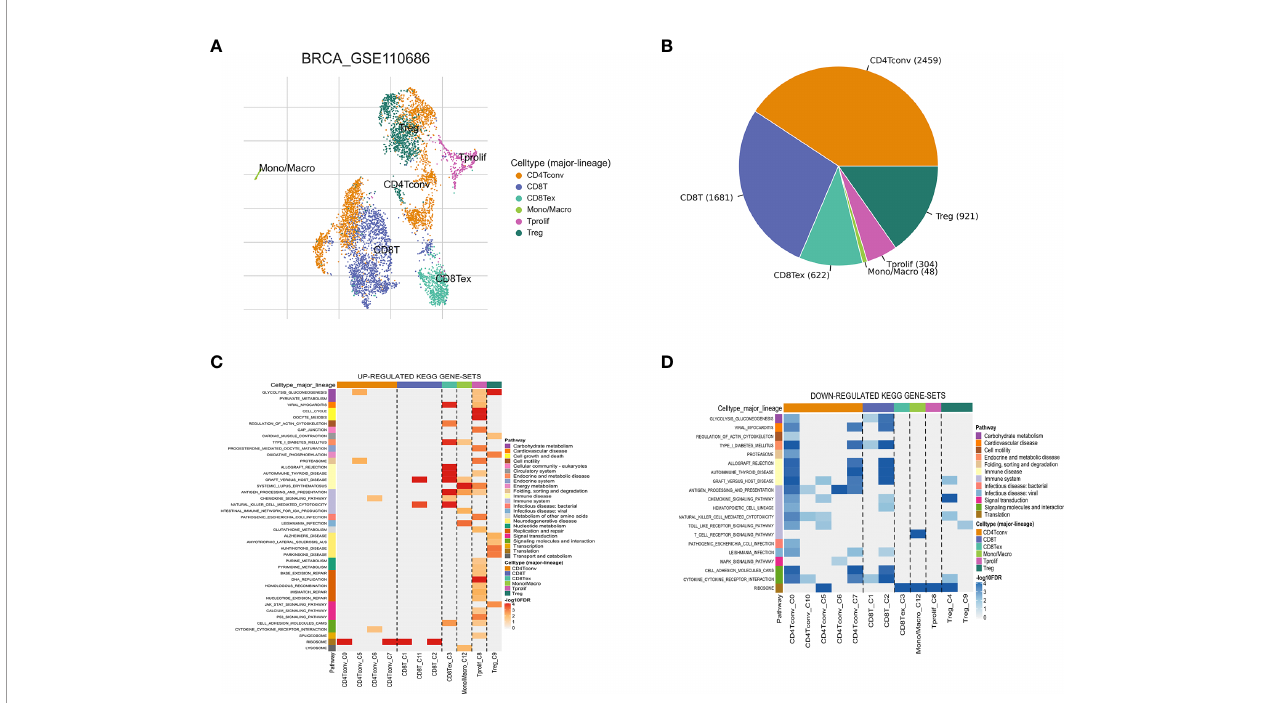
FIGURE 2 | Breast cancer single-cell data analysis based on the GSE110686 dataset. (A) UMAP plots with cells colored by cell type are displayed. (B) The pie plot shows the cell number distribution of each cell type. Heatmap showing enriched up- (C) or down-regulated (D) pathways identi fi ed based on differential genes in each cell